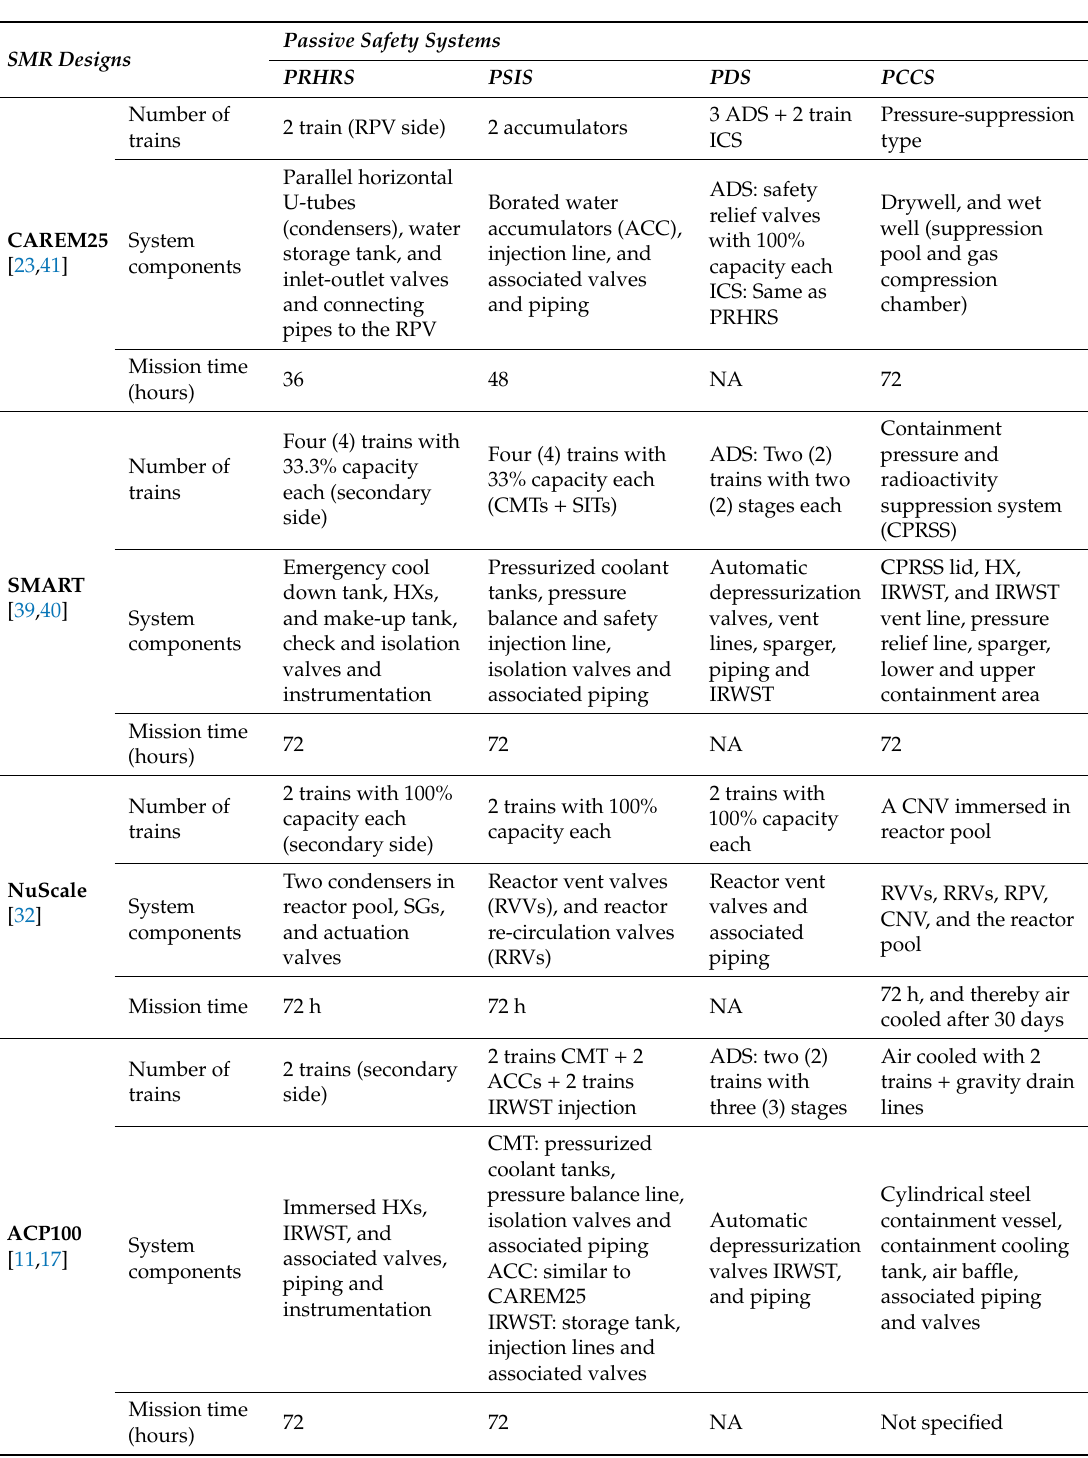
Table 5. Comparison of passive safety features in iPWR-type SMRs [18]. Reproduced from [18], IAEA.: